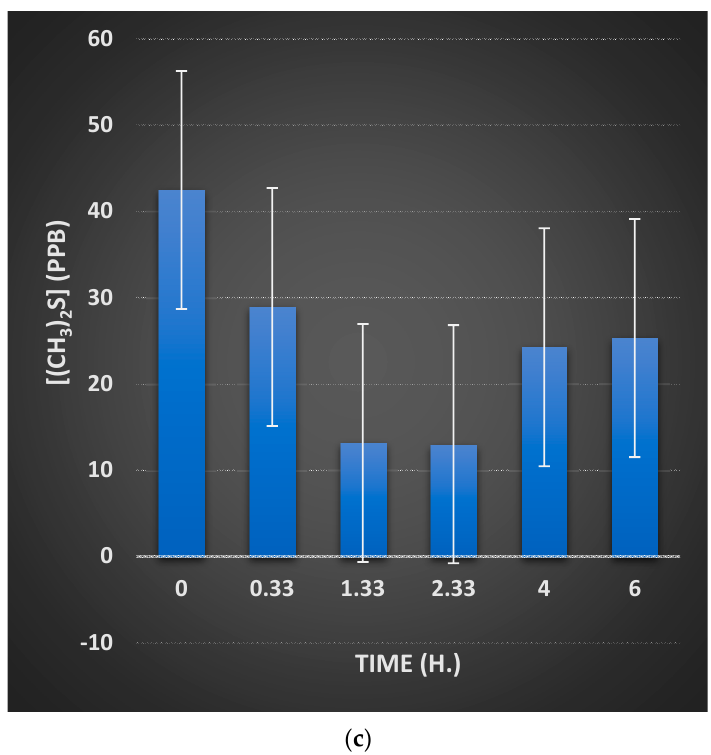
Figure 6. Bar diagram representations of mean±95% confidence intervals (CIs) oral cavity volatile sulfur compound (VSC) concentrations at each study time-point (0.00–6.00 h.) for (a) H 2 S, ( b ) CH 3 SH and ( c ) (CH 3 ) 2 S (ANOVA model 3). The 95% CIs include contributions from the ‘between-participants’ and the participant x treatment and participant x sampling time-point sources of variation, and hence they appear much wider than those computed from the error (residual) variance component alone.